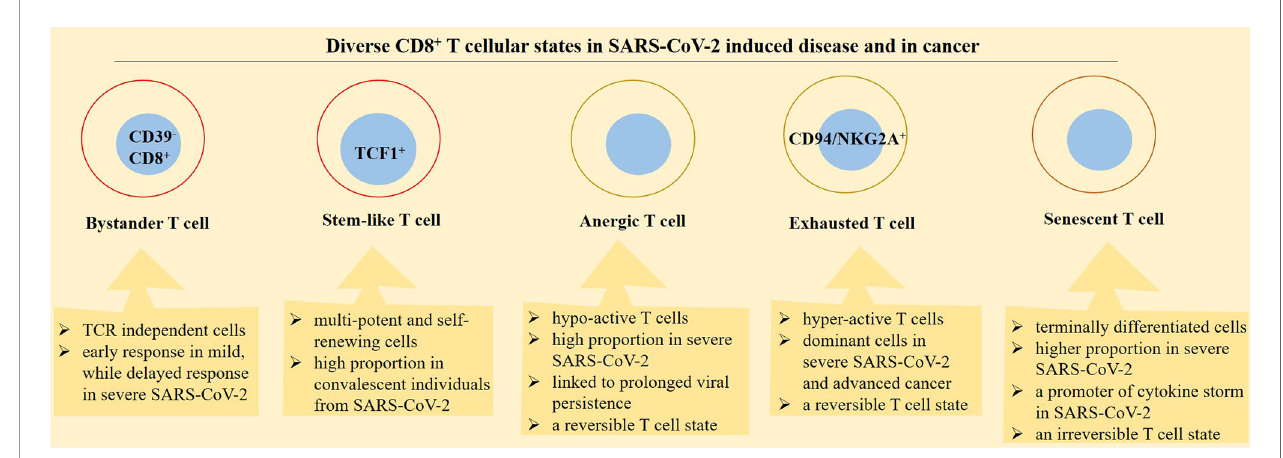
FIGURE 4 | Diverse functional pro fi le of different CD8 + T-cell states in patients with a SARS-CoV-2-induced disease and cancer. Bystander, stem-like, anergic, exhausted, and senescence are diverse cellular states in relation with CD8 + T cells. The activity of bystander cells is independent on T-cell receptors (TCRs). Stem- like CD8 + T cells are placed in designated immune niches and act for formation of effector T cells. Anergic T cells are hypo-reactive, whereas exhausted T cells are hyperreactive but both cellular states are reversible. Senescence is a term used for terminally differentiated T cells and is considered as an irreversible T-cell